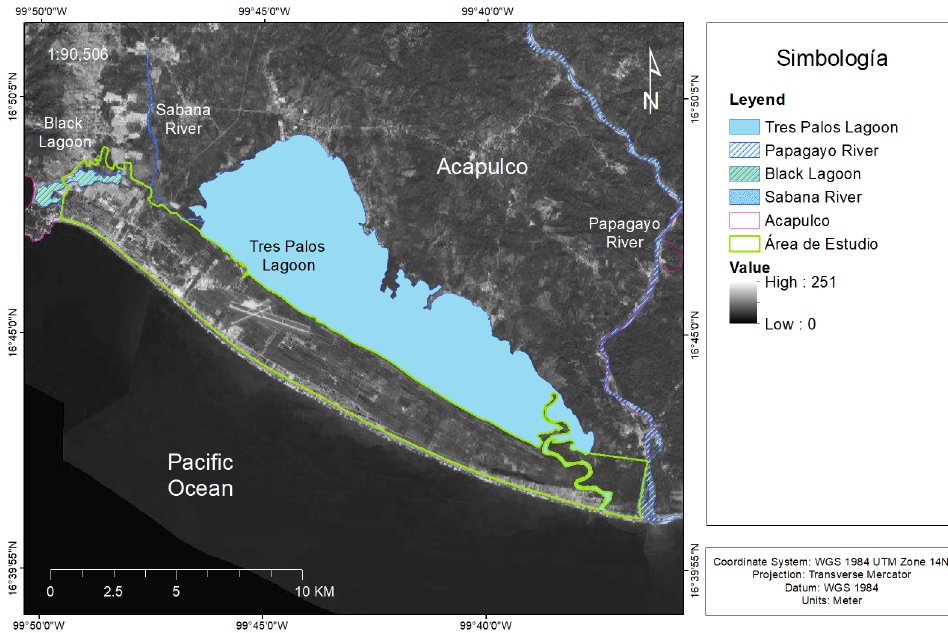
Figure 3. The raster dataset was created from several raster datasets arranged in a mosaic. Once the mosaic data were obtained, a series of contour lines was created in Global Mapper 20 from the terrain grid. In this way, equally spaced contour lines were generated at intervals that were as small as possible from the elevation grid data entered into ArcGIS (10 cm). However, we also experimented with distances between 5 m and 1 cm, with more significant and lesser degrees of success. Next, the terrestrial LiDAR point cloud was processed on a contour map (Figure 4A).